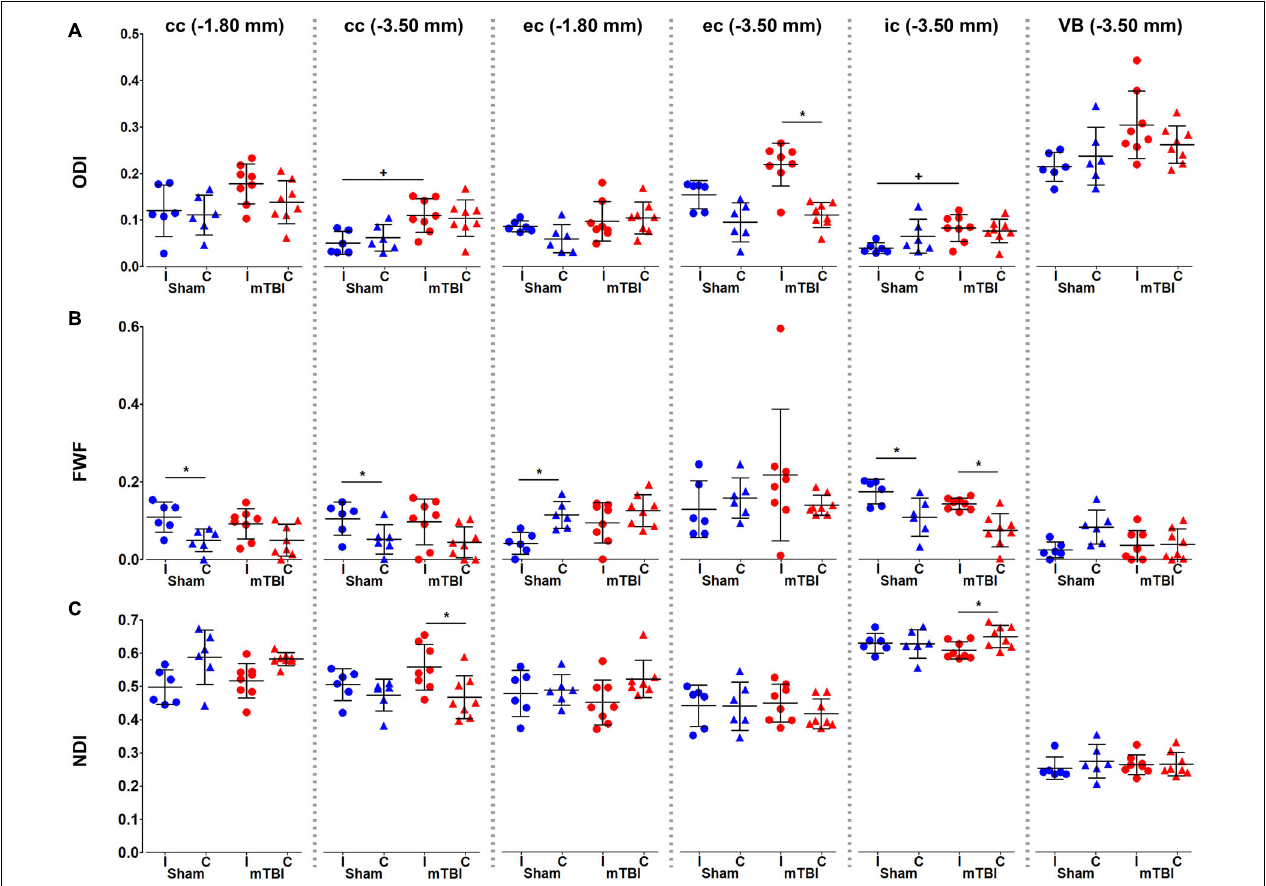
FIGURE 6 | NODDI metrics, ODI (A) , FWF (B) , and NDI (C) , were analyzed in the corpus callosum and external capsule at –1.80 and –3.50 mm, and the internal capsule and ventrobasal complex at –3.50 mm from bregma. Sham-operated animals are indicated in blue and mTBI in red, while ipsi- and contralateral hemispheres are represented by circles and triangles, respectively. Results are shown as mean and standard deviation, and paired (*) t -test comparing ipsi- and contralateral sides within animals (* q < 0.05) or unpaired (+) t -test comparing the same hemisphere between sham-operated and mTBI rats ( + q < 0.05), both FDR-corrected. cc, corpus callosum;ec, external capsule; ic, internal capsule; FWF, free water fraction; NDI, neurite density index; ODI, orientation dispersion index; VB, ventrobasal